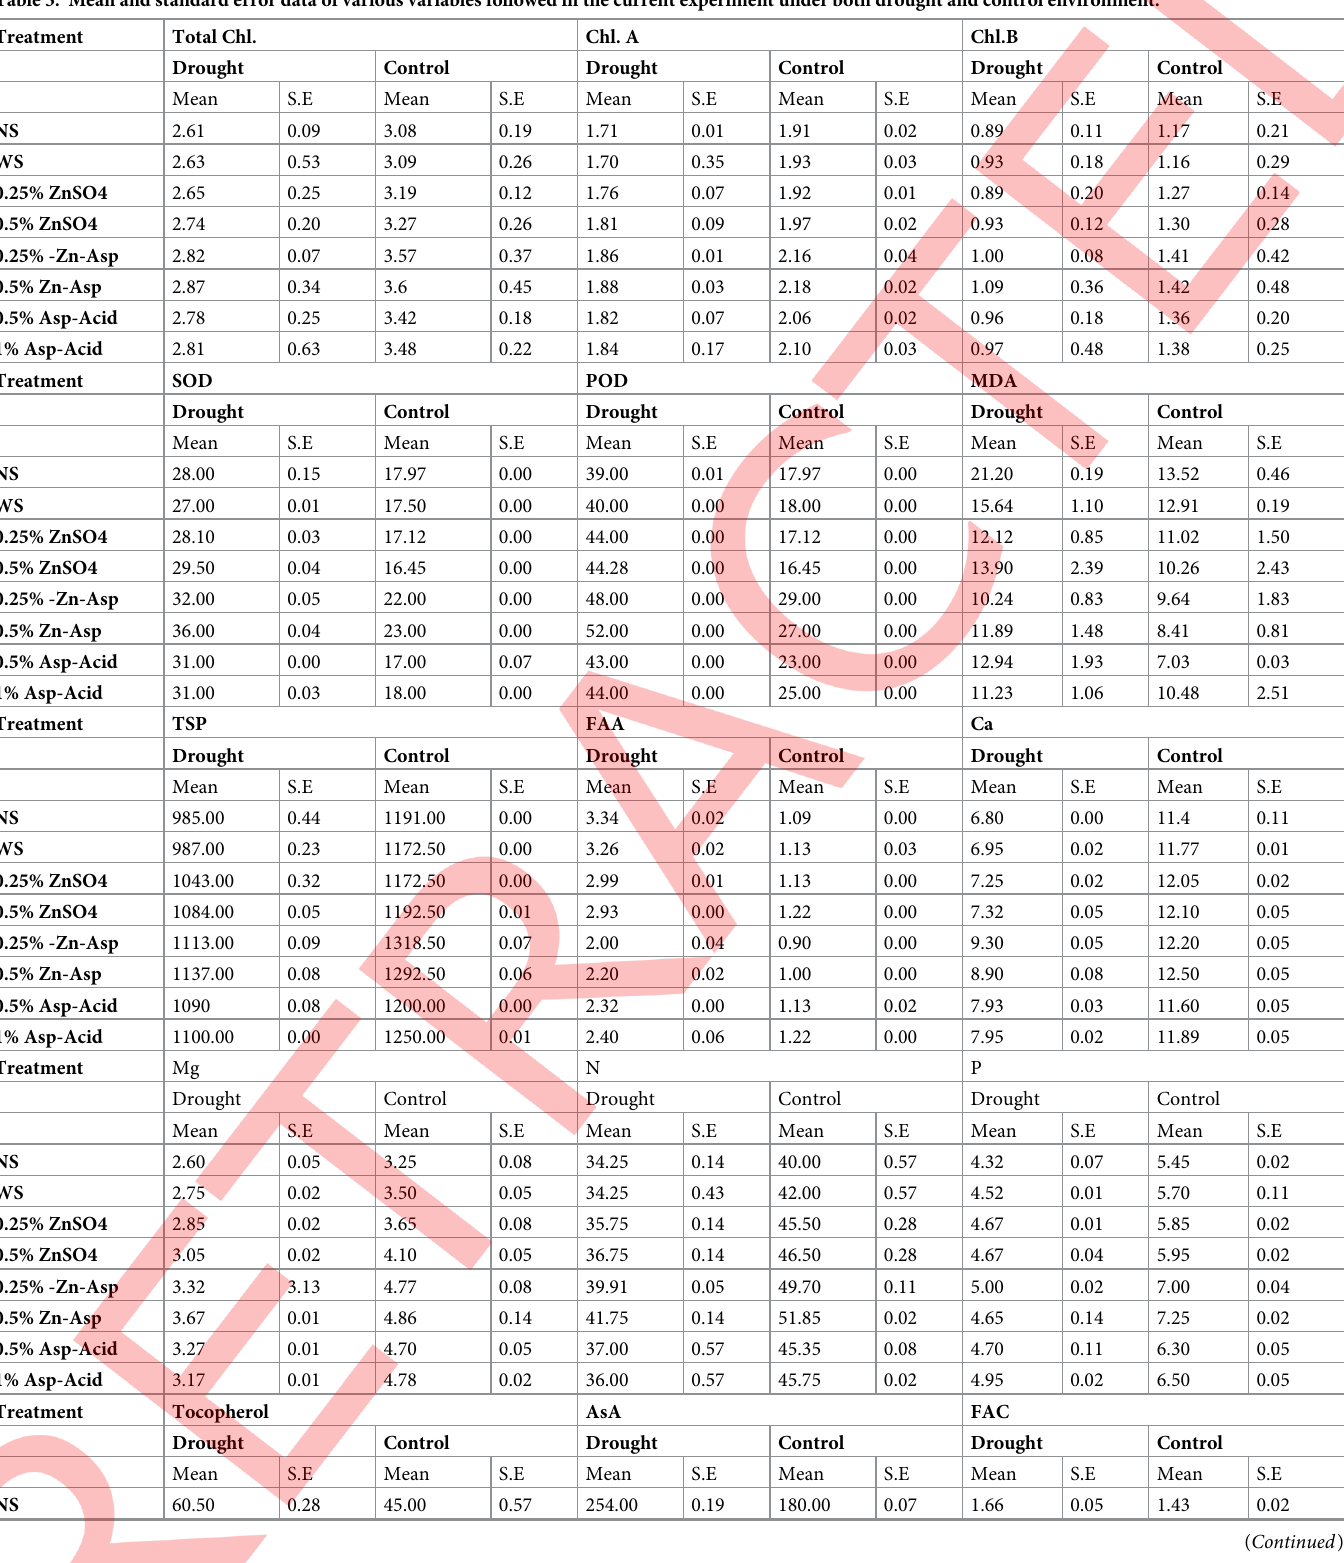
Table 3. Mean and standard error data of various variables followed in the current experiment under both drought and control environment. Treatment Total Chl. Chl. A Chl.B Drought